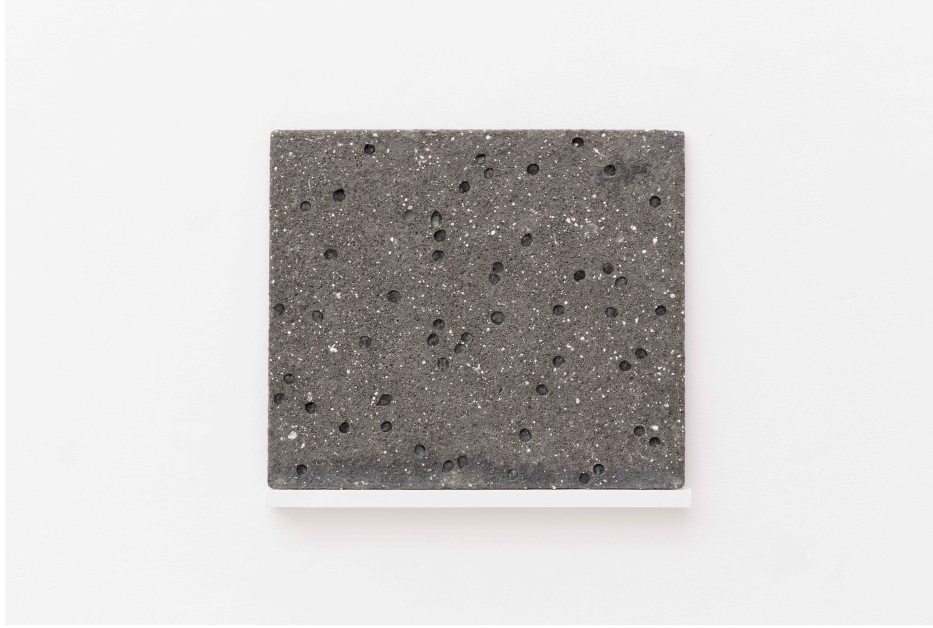
Figure 7: Jack Vickridge, Untitled, 2016, Concrete and pigment, 44.5 x 38.5 x